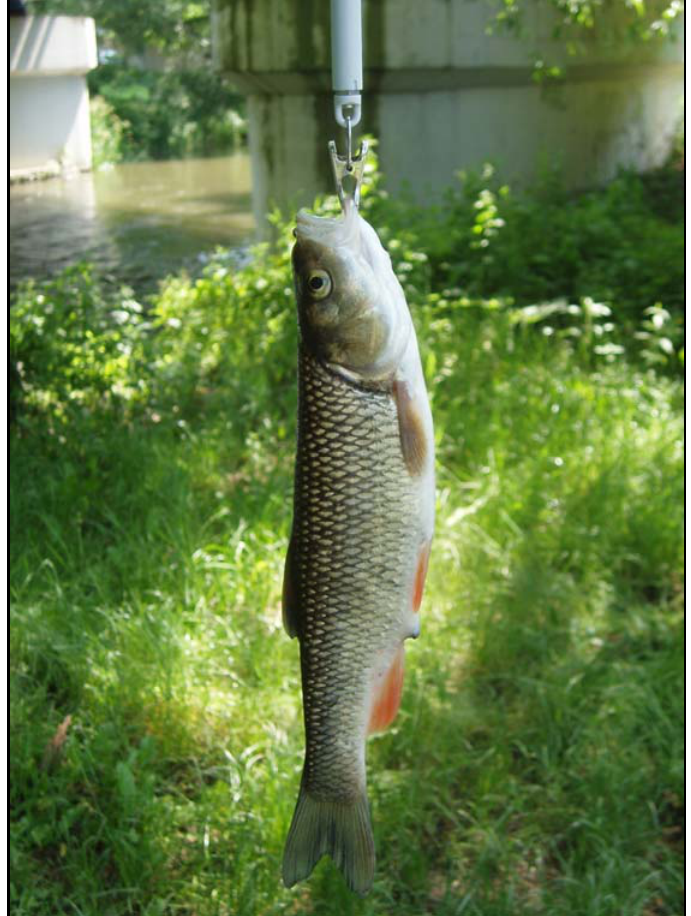
Figure 3. The indicator species-chub ( Leuciscus cephalus